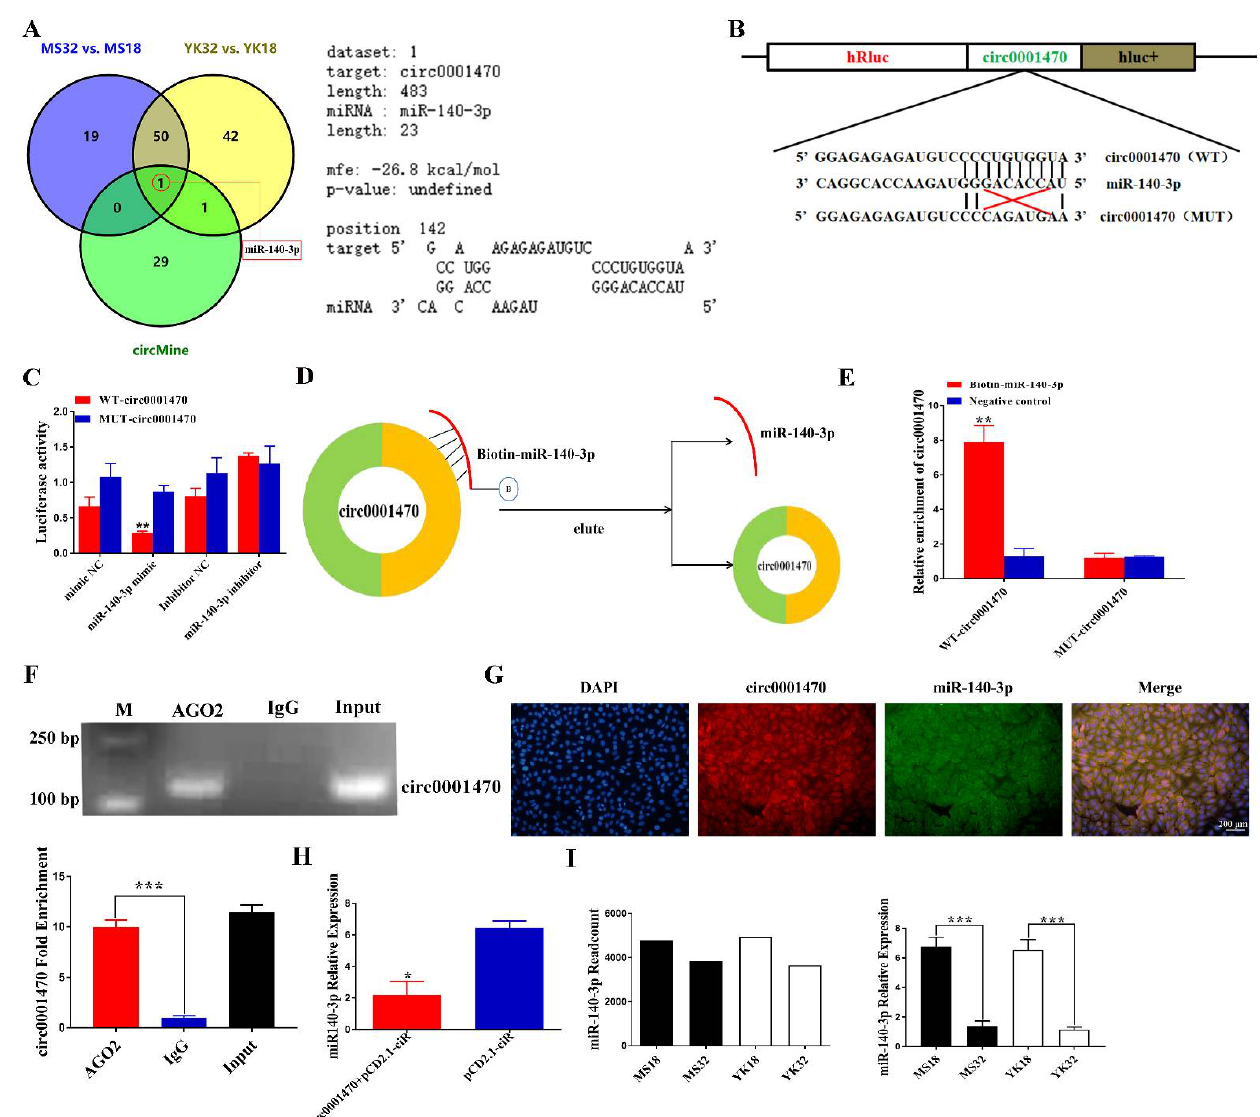
Figure 4. Circ0001470 decreased miR-140-3p levels, serving as a microRNA sponge in EECs. ( A ) Venn diagram demonstrating the possible binding of circ0001470 to differentially expressed miRNAs in endometrial tissues of pigs at different gestation days. An analysis of the binding free energy of circ0001470 to miR-140-3p by RNAhybrid database. ( B ) Schematic diagram showing the design of luciferase reporters with the WT-circ0001470 and the site-directed MUT-circ0001470, respectively. ‘TGTGGT’ is the ‘seed sequence’ of miR-140-3p; mutant nucleotide is ‘CAGATG’. ( C ) Luciferase assay was conducted after transfection, WT-circ0001470 or its mutant luciferase reporter vectors were co-transfected with miR-140-3p mimic or mimic NC (miR-140-3p inhibitor or inhibitor NC) into PK15 cells. ( D ) Schematic diagram displaying the pull-down of circ0001470 by a biotin-labeled miR-140-3p probe. ( E ) RNA pulldown assay was performed with biotin-miR-140-3p, control or WT-circ0001470 or MUT-circ0001470 by using EECs extracts. RNA levels of miR-140-3p in immunoprecipitates were detected by qRT-PCR. ( F ) AGO2 RNA immunoprecipitation assay of circ0001470 in EECs. Semi-quantitative PCR and qRT- PCR results of AGO2 pull-down circ0001470. ( G ) The cellular position of circ0001470 (red) and miR-140-3p (green) in cells was observed by FISH (scale bars, 200 μm). ( H ) qRT-PCR analysis of miR-140-3p expression in EECs treated with overexpression circ0001470. ( I ) The miR-140-3p levels in Yorkshire and Meishan endometrium at 18 and 32 days of pregnancy. Data are presented as the mean (n = 3) standard deviation. Student’s t -test; * p < 0.05, ** p < 0.01, *** p < 0.001.